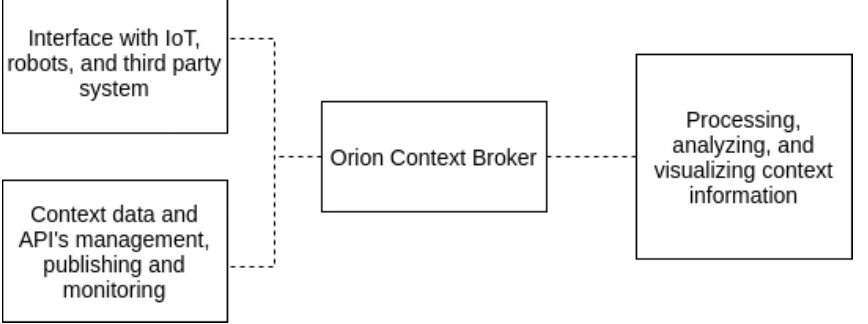
Figure 5. FIWARE Orion Context Broker